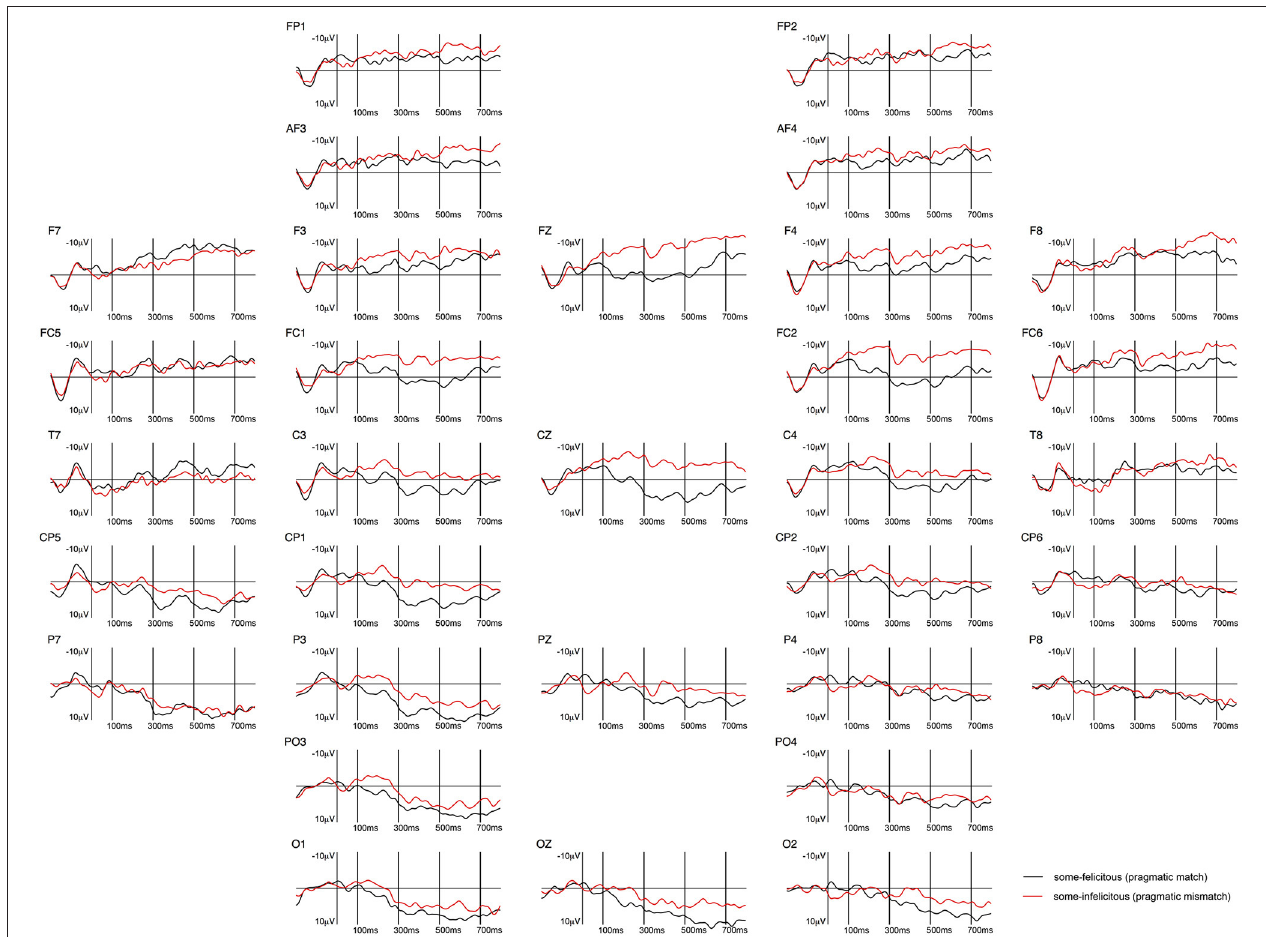
FIGURE 3 | Grand-averaged ERPs recorded in children, time-locked to the presentation of the word “Ein paar” ( some ) for the some -felicitous condition (black line) compared to the some -infelicitous condition (red line).